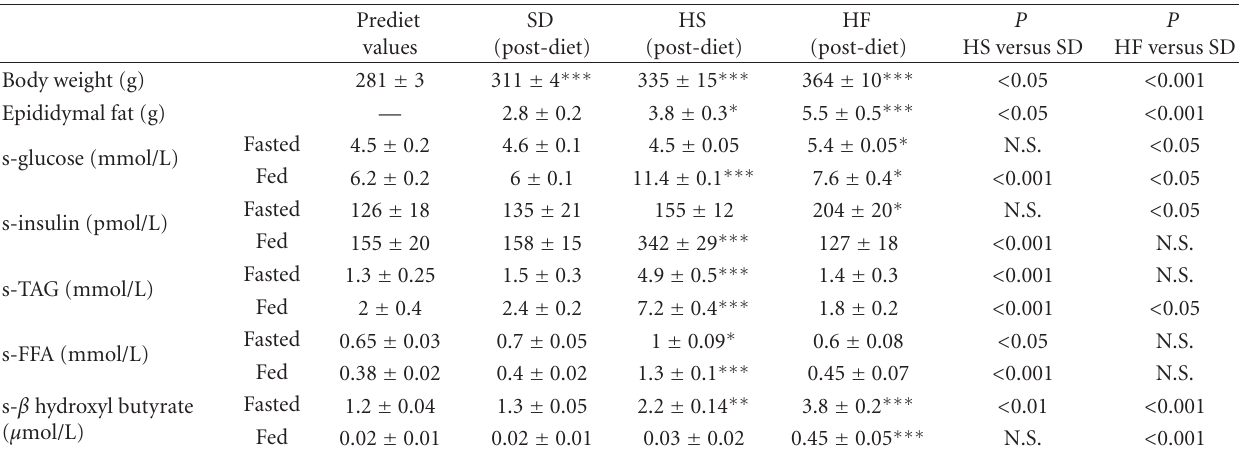
Table 1: Characteristics of experimental groups.